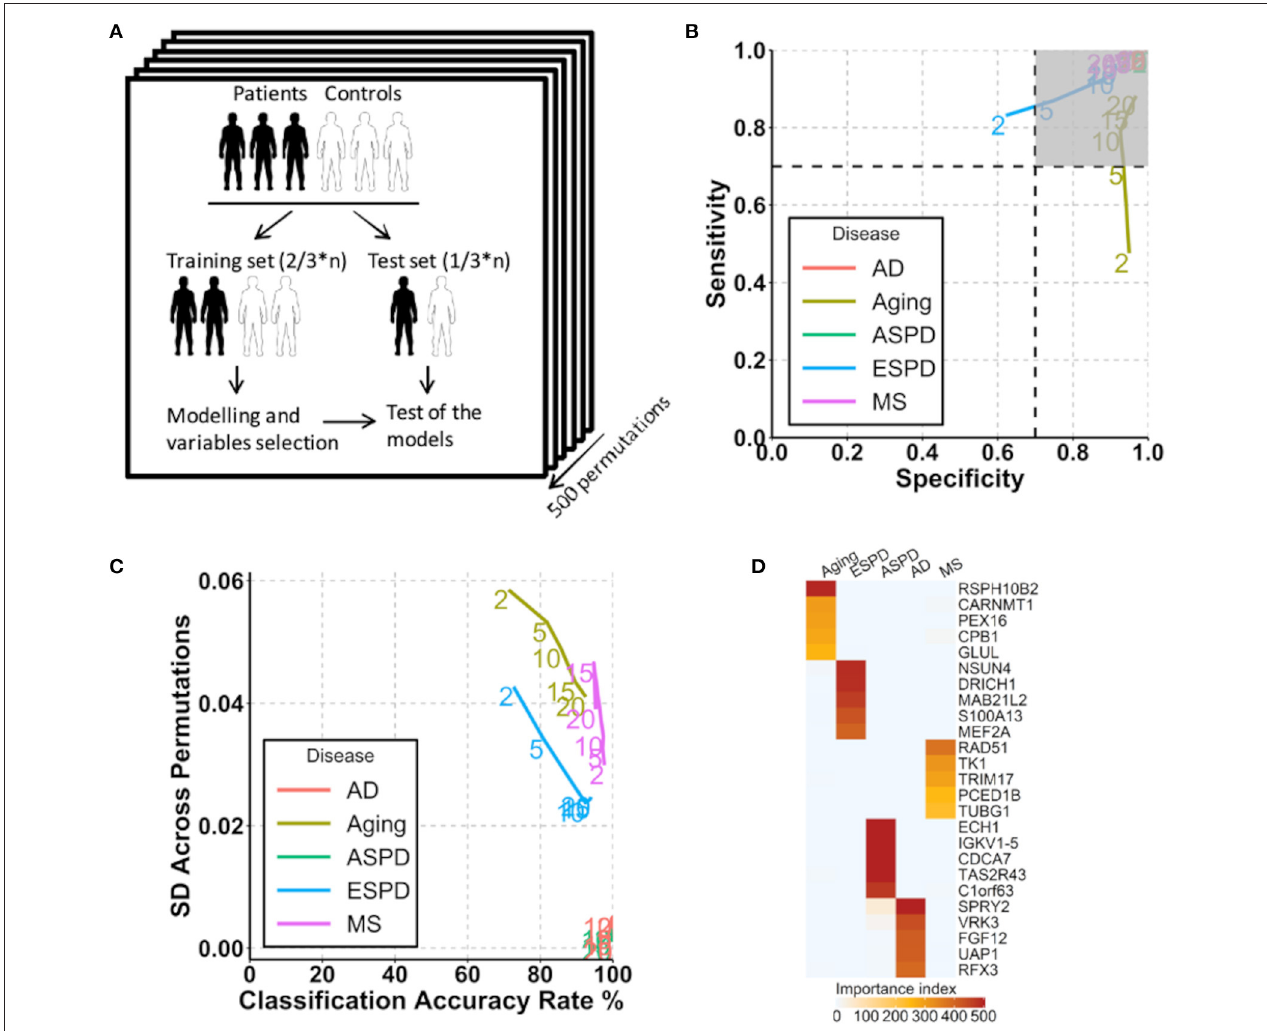
FIGURE 4 | Prediction of aging and age-related diseases using autoantibodies. (A) Strategy for modeling and autoantibody selection for the prediction of aging and neurodegenerative diseases. The mean classifications accuracy rate, sensitivity, and specificity were calculated across the 500 resampled test data sets. (B) Path plot of sensitivity and specificity for models includes the 2 to 20 top selected autoantibodies for aging and neurodegenerative diseases. The numbers of autoantibodies are indicated by the numbers in the lines within the plot. Gray quadrant indicates the area of the figure in which sensitivity and specificity are higher than 0.7. (C) Path plot of the accuracy rate of classification and its SD across 500 permutations for models includes the top 2 to 20 selected autoantibodies for aging and neurodegenerative diseases. A small SD across permutations (close to 0) demonstrates a high stability of the model. (D) Heatmap of importance index of top 5 selected autoantibodies in aging and neurodegenerative